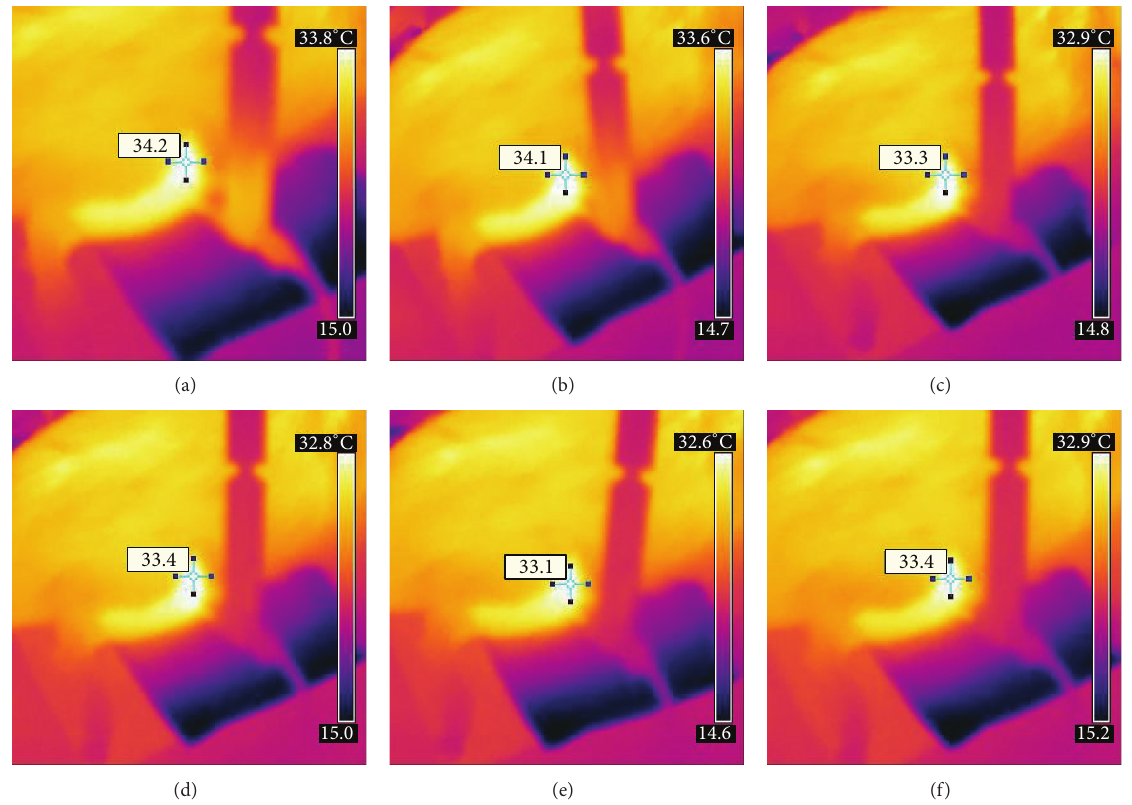
Figure 7: Six thermal images from an anesthetized rat before (a), during ((b)–(d)), and after ((e) and (f)) red light stimulation at the right Zusanli acupoint. Note the decrease of the temperature during and after red light